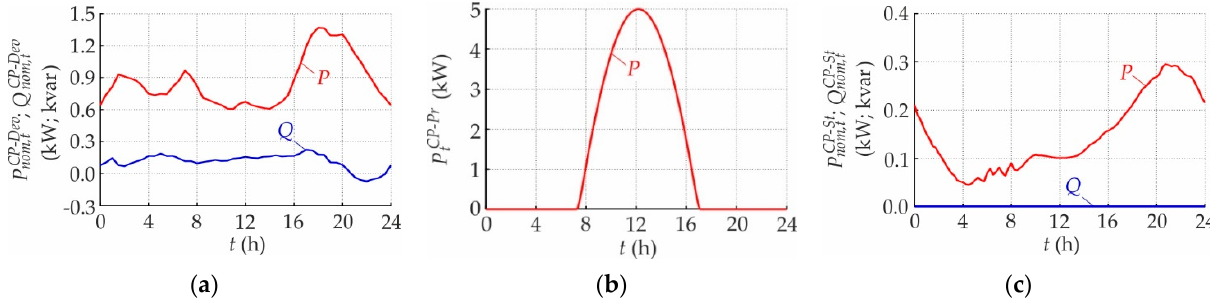
Figure 4. Structure of the test link chain: ( a ) overview; ( b ) residential CP_Link-Grids; ( c ) rural LV_Link-Grid; ( d ) MV_Link-Grid.